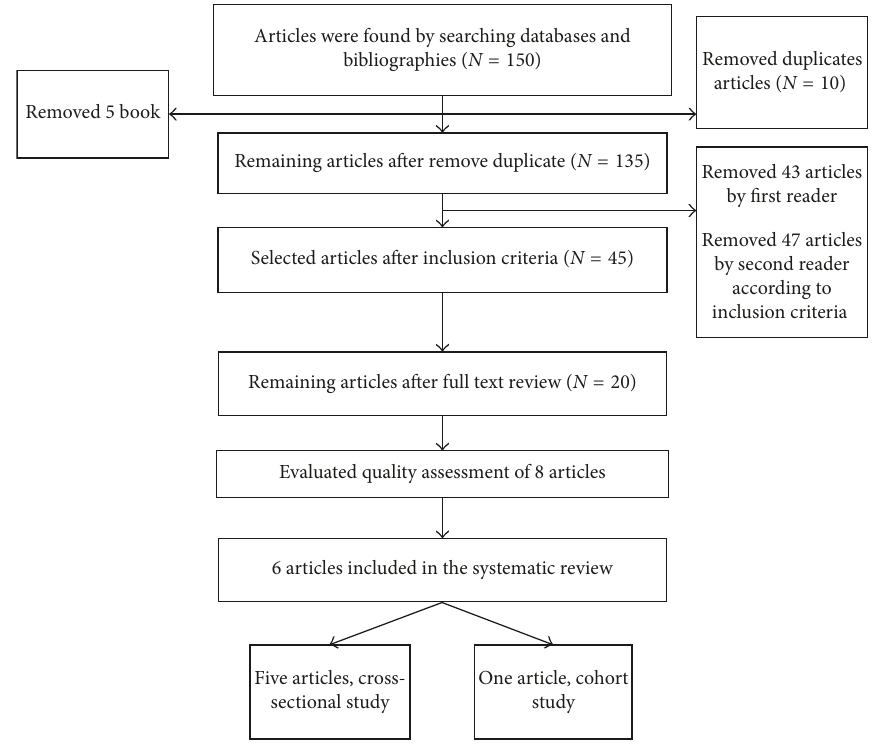
Figure 1: Flow chart of the process of study entering in a systematic review study. Table 2: Methodology of studies included in the systematic